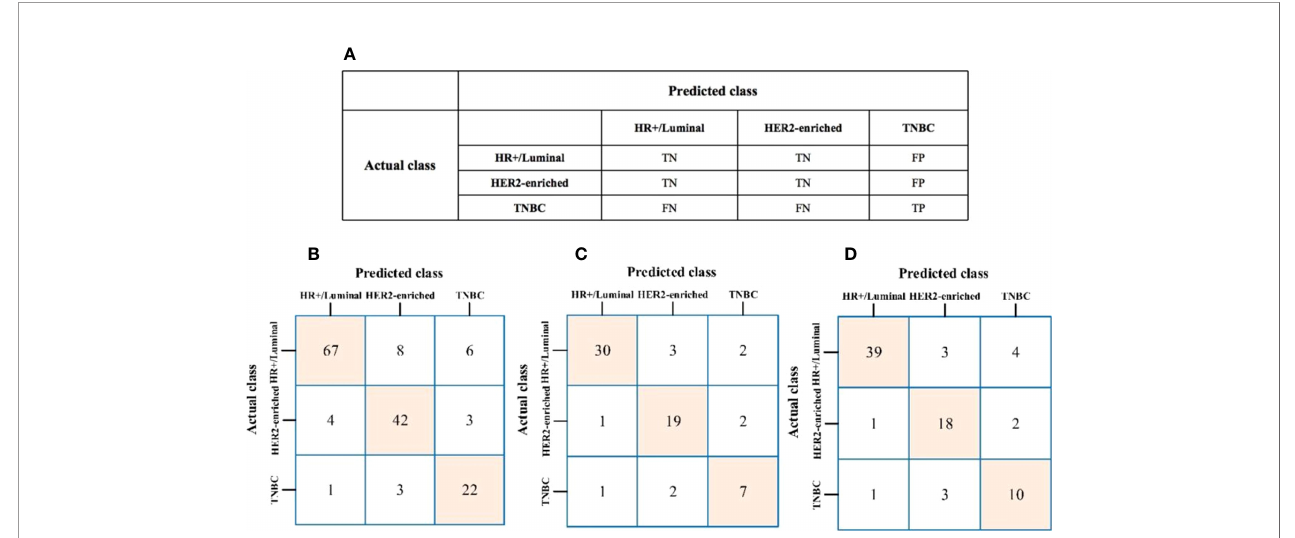
FIGURE 3 | (A) The prediction results of confusion matrix when TNBC was labeled as the target. TP, true positive; TN, true negative; FP, false positive; FN, false negative. (B – D) Confusion matrix of the combined model to the training, test, and external validation sets, respectively.